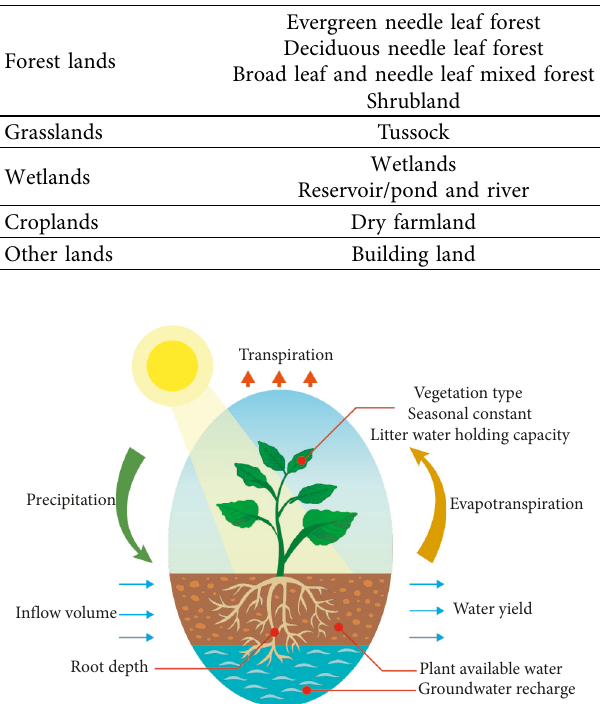
Figure 1: Water balance model